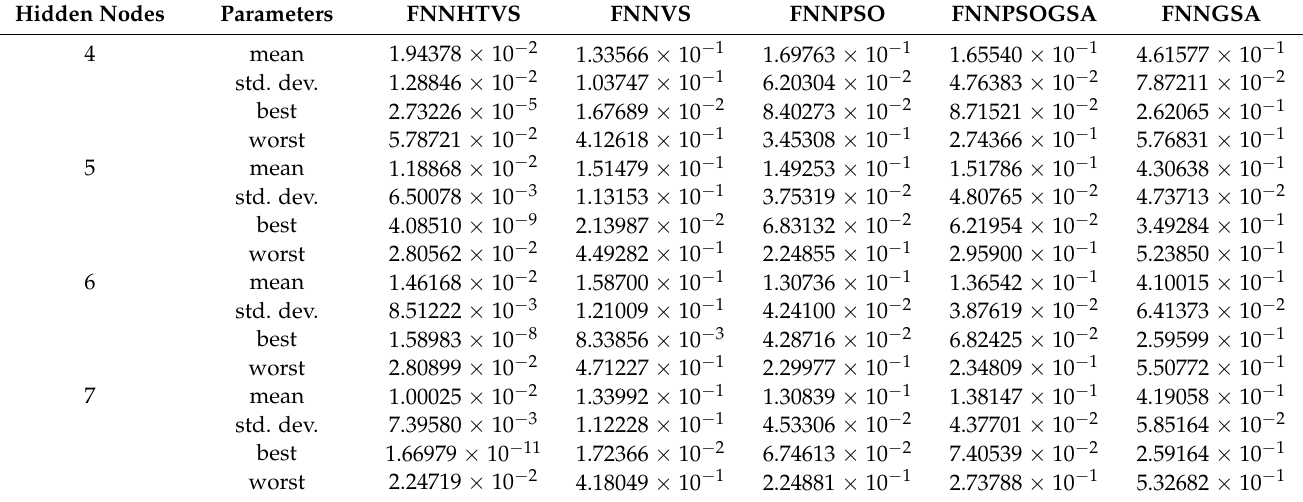
Table A3. Statistical results (MSE) in the wine recognition